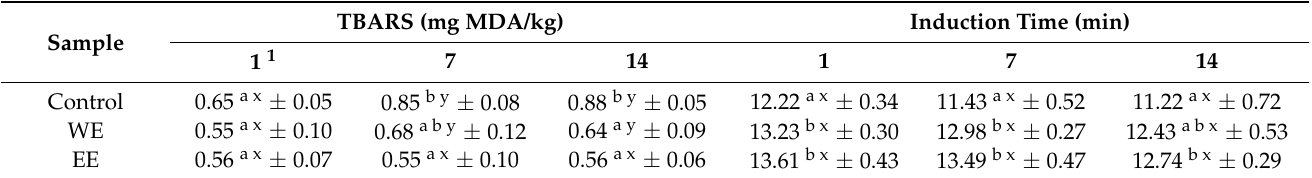
Table 2. Evolution of TBARS values and induction times of chicken meatballs during refrigerated